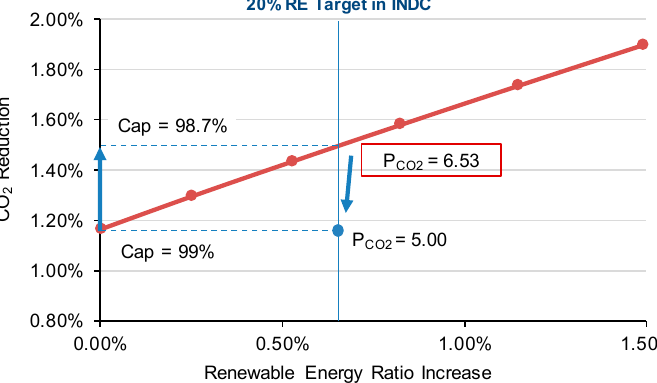
Figure 7. CO 2 reduction and AREI under the same CO 2 price level.